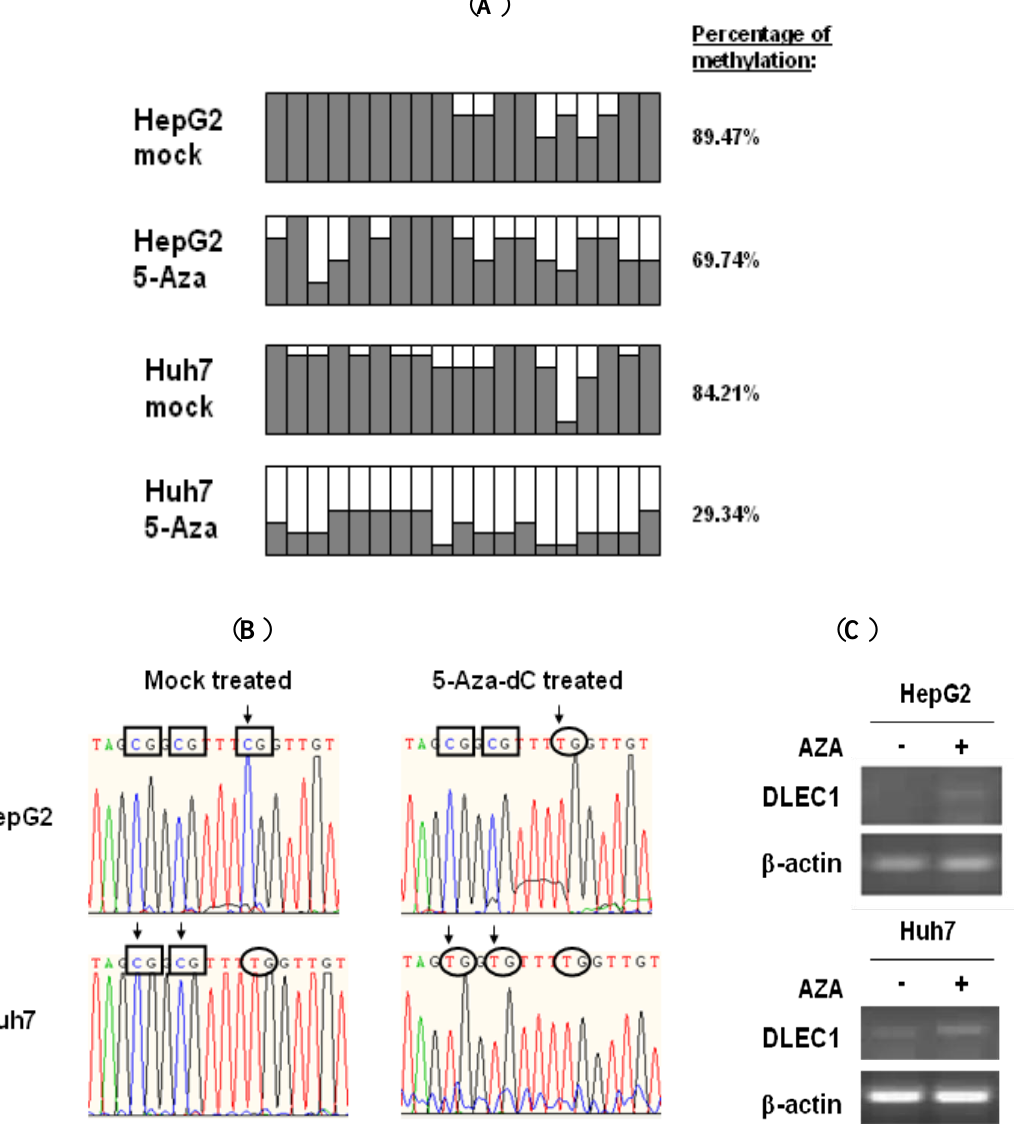
Figure 1. DLEC1 promoter hypermethylation and its expression in HCC cell lines. (A) Promoter methylation analysis by bisulfite genome sequencing of DLEC1 5’ CpG sites in both of HepG2 and Huh7 with or without treatment of 5-Aza-dC. 19 CpG dinucleotides were analyzed in the 5’ promoter of DLEC1 (represented as 19 columns). 6–8 clones of each sample were sequenced and the results were presented as follow: Open area indicates the percentage of unmethylated CpG sites, while dark area indicates percentage of methylated CpG sites. The quantitative result in percentage of methylated CpG sites was listed on the right of the column groups. Three independent experiments were carried out and representative result from one of them is listed here. (B) Representative bisulfite sequencing results of the DLEC1 promoter region showing the CpG methylation status of bisulfite treated DNA from two cell lines mock treated or 5-Aza-dC treated. Rectangles indicate the methylated CpG sites, while ellipses for unmethylated CpG sites. Arrows mark the CpG sites whose methylation status was changed by 5-Aza-dC treatment. (C) RT-PCR analysis of DLEC1 expression in two cell lines mock treated or 5-Aza-dC